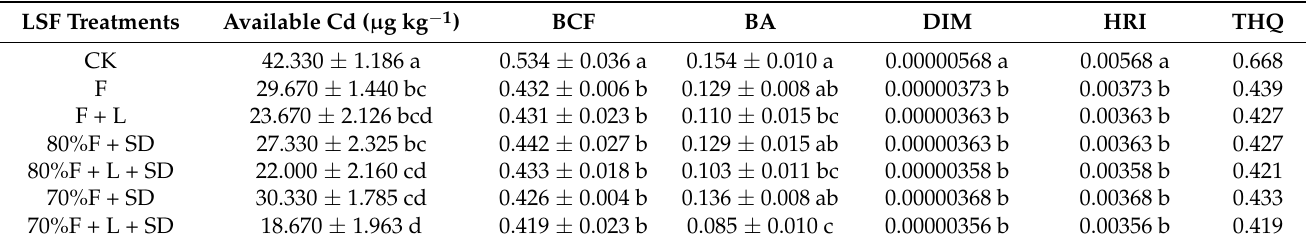
Table 5. Effect of LSF on soil available Cd concentration, Cd bioconcentration factor (BCF), and Cd bioavailability (BA) of A. selengensis , daily intake of Cd (DIM), Cd-associated health risk index (HRI) and the target hazard quotient (THQ) compared to A. selengensis cultivated on Cd-contaminated soil. All values are means of three replicates ± standard errors with different lowercase letters showing significant variability among treatments ( p <